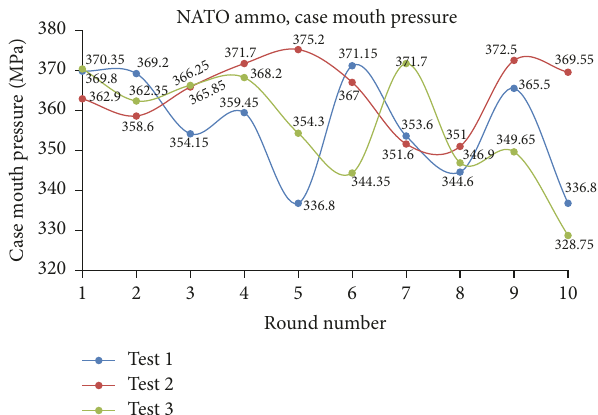
Figure 29: Case mouth pressure measured with piezo sensor using standard NATO